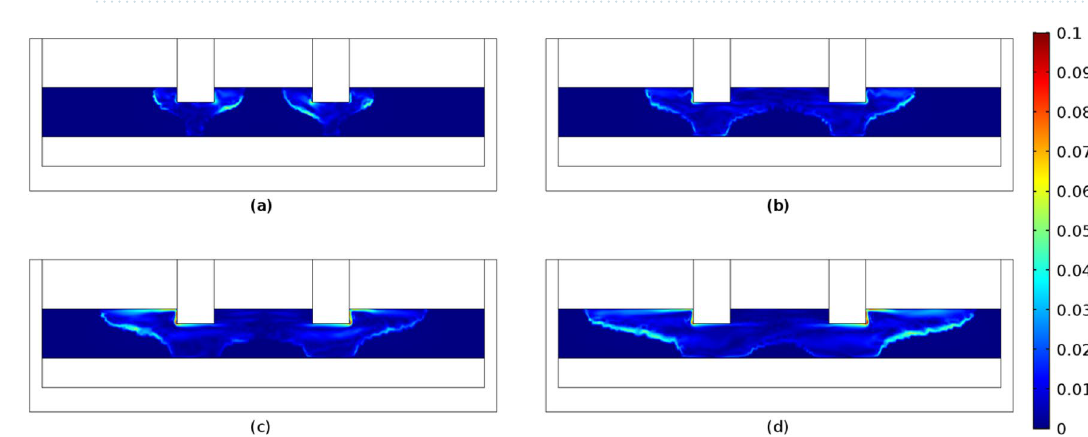
Figure 10. Velocity distribution (m/s) in the slag region with respect to times ( a ) 2000s, ( b ) 3000 s, ( c ) 4000 s and ( d ) 5000